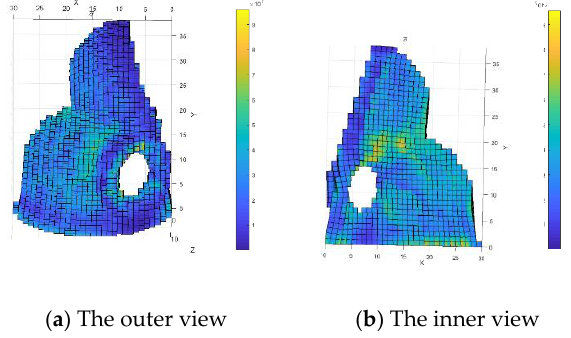
Figure 13. The reconstructed model in MATLAB.